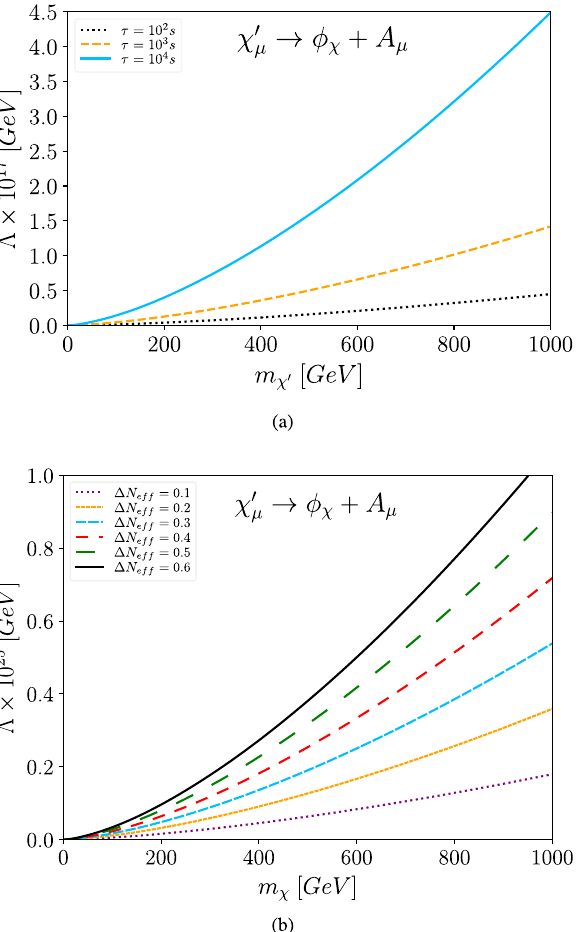
Fig. 5 Plot of (cid:2) as a function of the χ and χ (cid:4) masses for the case where χ (cid:4) and χ are spin-1/2 particles. a (cid:2) × m χ (cid:4) curves built from Eq. (24), using τ = 10 2 , 10 3 and10 4 s. b (cid:2) × m χ curves constructed